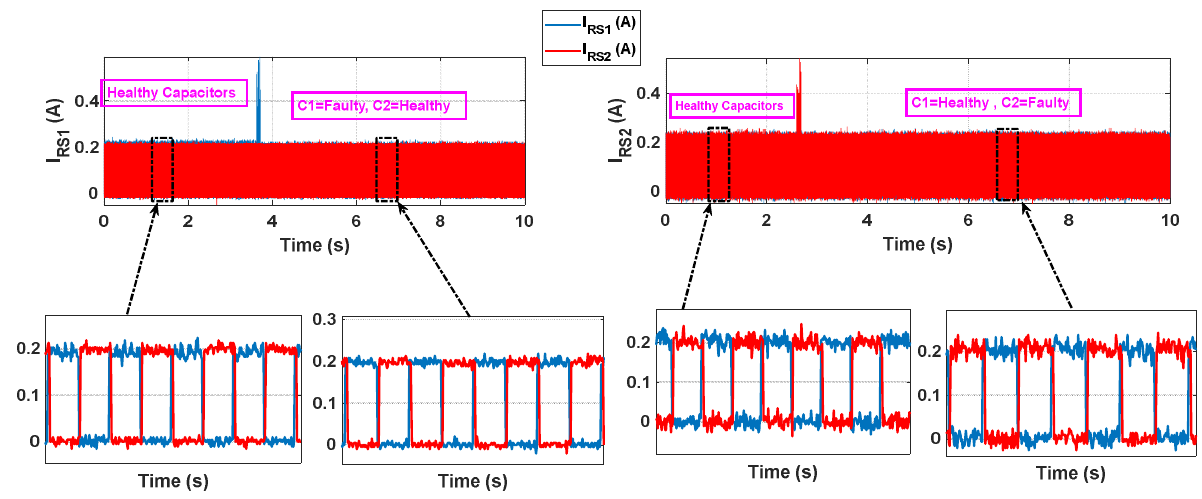
Figure 9. LED fixtures’ instantaneous currents I Rs 1 and I Rs 2 , showing the fault transience in the two capacitors (Cap1 and Cap2).